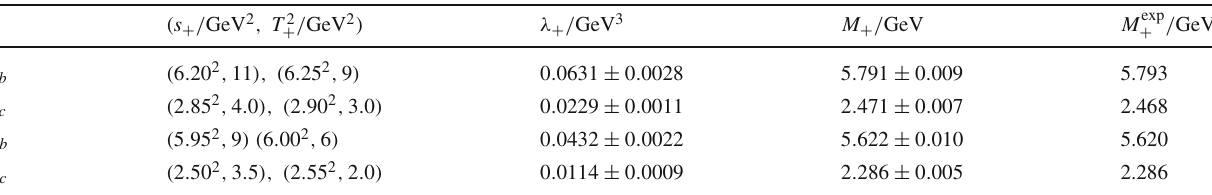
Table 1 The predictions of the pole residues and masses. For compari- son, the experimental values of heavy baryons are also shown. Optimal and suboptimal s + and T 2 + are given simultaneously. The central values for the pole residues and masses are taken at optimal s + and T 2 + , and